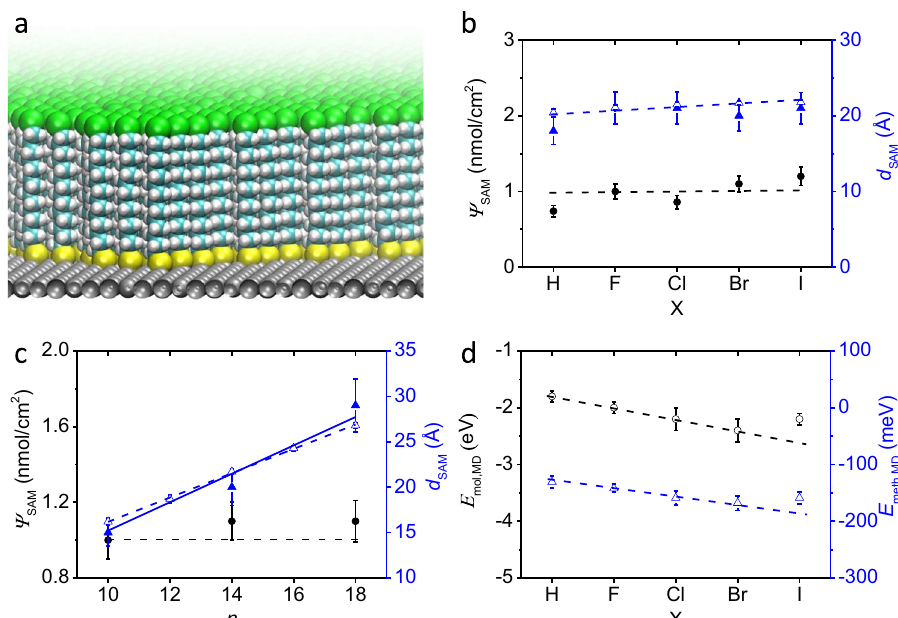
Fig. 2 Characterization of the self-assembled monolayers (SAMs). a Representative slice-through of a large-area Ag – S(CH 2 ) 14 I SAM structure calculated by molecular dynamics (MD) computer simulations. b Surface coverage ( Ψ SAM ) of Ag – S(CH 2 ) 14 X SAMs as a function of X determined with angle-resolved X-ray photoelectron spectroscopy (ARXPS, fi lled circles) and thickness of SAM ( d SAM ) determined with ARXPS ( fi lled triangles) and MD (empty triangles). c Ψ SAM of Ag – S(CH 2 ) n Br SAMs as a function of n determined with ARXPS ( fi lled circles) and d SAM determined with ARXPS ( fi lled triangles) and MD (open triangles). The solid and dashed blue lines are linear fi ts to the experimental and MD data with R 2 of 0.94 and 0.99, respectively. The horizontal dashed line in panels b and c indicates the Ψ SAM used in the MD calculations. d Computed MD packing energy per molecule E mol,MD and per methylene – CH 2 – unit E – S(CH meth,MD of Ag 2 ) 14 X SAMs as a function of X. Dashed lines are guides to the eye. The errors on the XPS data represent instrumental and of 10% in total (see Section S4). The error bars in the MD data represent the standard deviations in the time- and molecule-averages calculated across 500 snapshots taken during the fi nal 50 ns of 100 ns of room temperature MD of 128-molecule Ag – S(CH 2 ) 14 X SAMs with the average experimental coverage of 1 nmol/cm 2 on